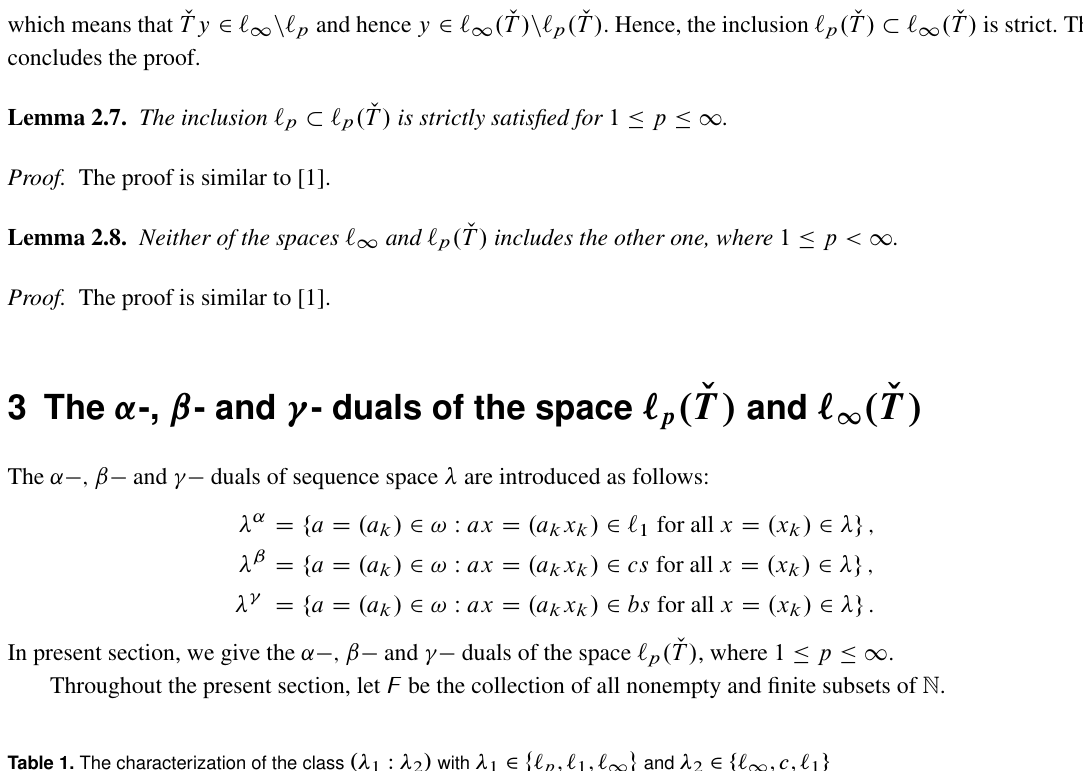
From To ` 1 c ` 1 ` p 1. 2. 3. ` 1 4. 7.